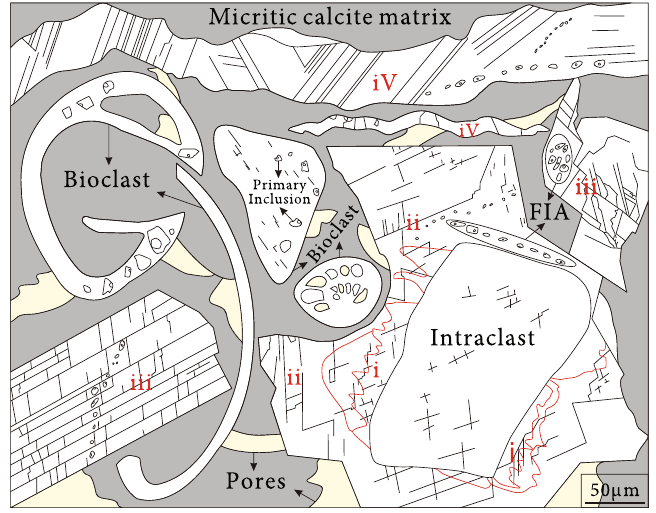
Figure 4: Schematic representation of di ff erent diagenetic sequences and fl uid inclusion stages. The serrated red lines show the boundary between (i) and (ii) calcite cements. The two phases cannot be distinguished in plane-polarized light. With cathodoluminescence illumination, the (i) overgrowth cements maintain the same nonluminescent properties as the intraclast, while the (ii) cements are brightly red luminescent, as shown in Figures 3(a) and 3(b). (i) Syntaxial calcite cement; (ii) (Early) Mesogenetic calcite cement; (iii) (Late) Mesogenetic calcite cement; (iv) (Late) Mesogenetic calcite